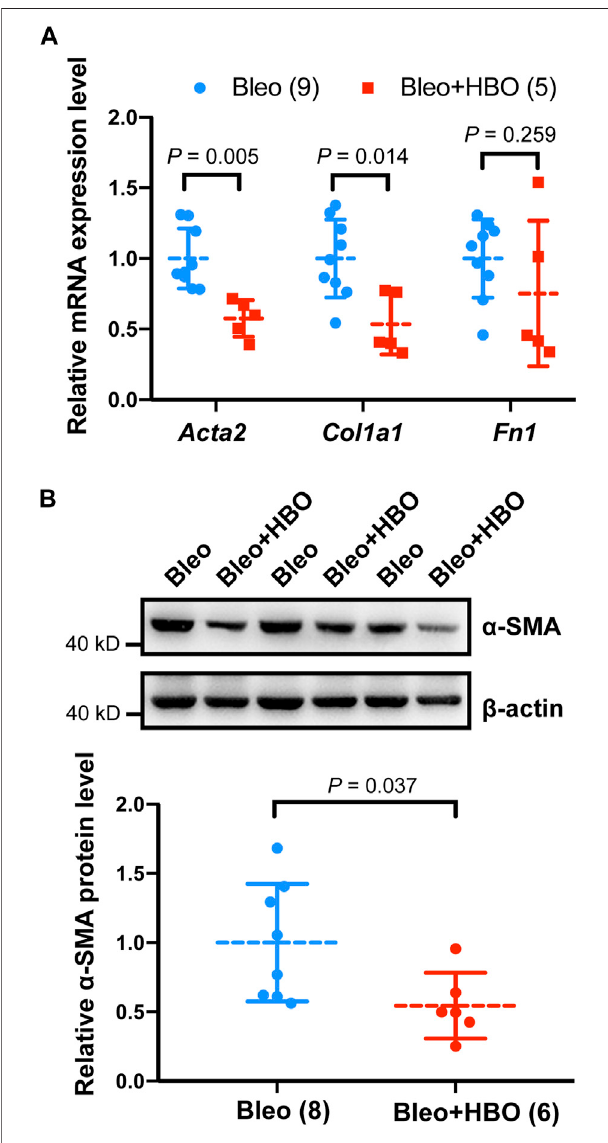
FIGURE 4 | Effects of repetitive HBO treatments on fi broblast activation and ECM deposition in mice lungs. (A) Fold change in the mRNA levels of Acta2 ( α -SMA), Col1a1 (collagen I), and Fn1 ( fi bronectin) in the lungs from bleomycin-challenged mice (Bleo) or bleomycin- challenged mice treated with repetitive HBO (Bleo + HBO). Actb ( β -actin) -normalized mRNA levels in the Bleo group were used to set the baseline value at unity. Data are mean ± s.d., with numbers of mice within each group and the p value indicated. (B) Protein expression of α -SMA in lungs from bleomycin-challenged mice (Bleo) or bleomycin-challenged mice treated with repetitive HBO (Bleo + HBO). β -actin was used as a loading control. In the graph, β -actin-normalized protein levels in the Bleo group were used to set the baseline value at unity. Data are mean ± s.d., with numbers of mice within each group and the p value indicated. Data in (A) were analyzed with the unpaired multiple t -test. Data in (B) were analyzed with the unpaired t